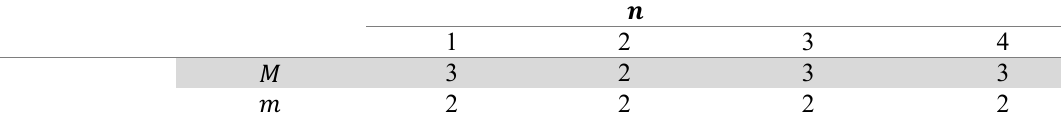
Min and max number of active projects (cid:1866) for synergy